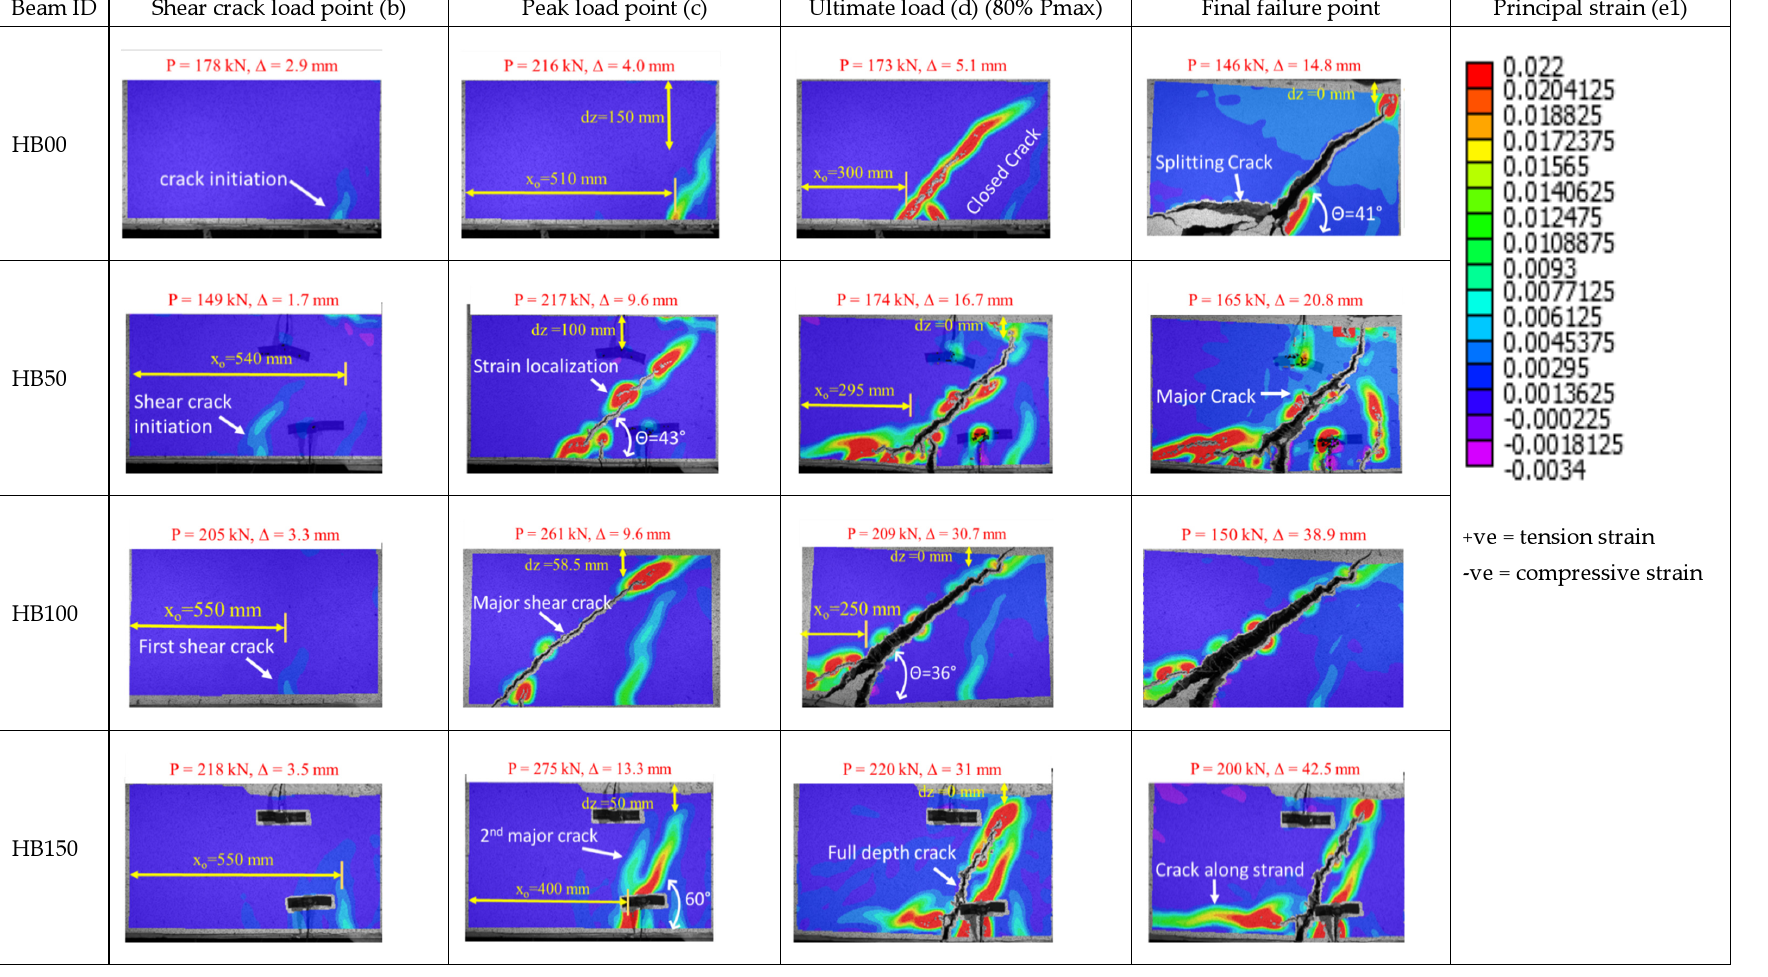
Figure 10. Strain variation in all test HB beams at various points of load–deflection